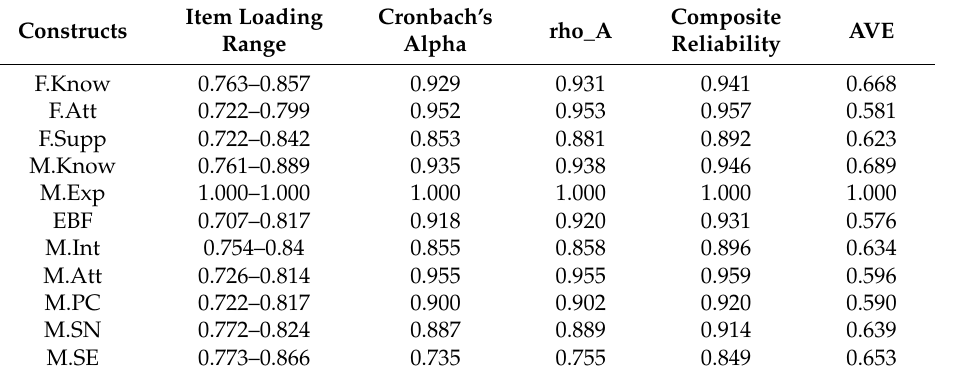
Table 4. Results of reliability and convergent validity measures.